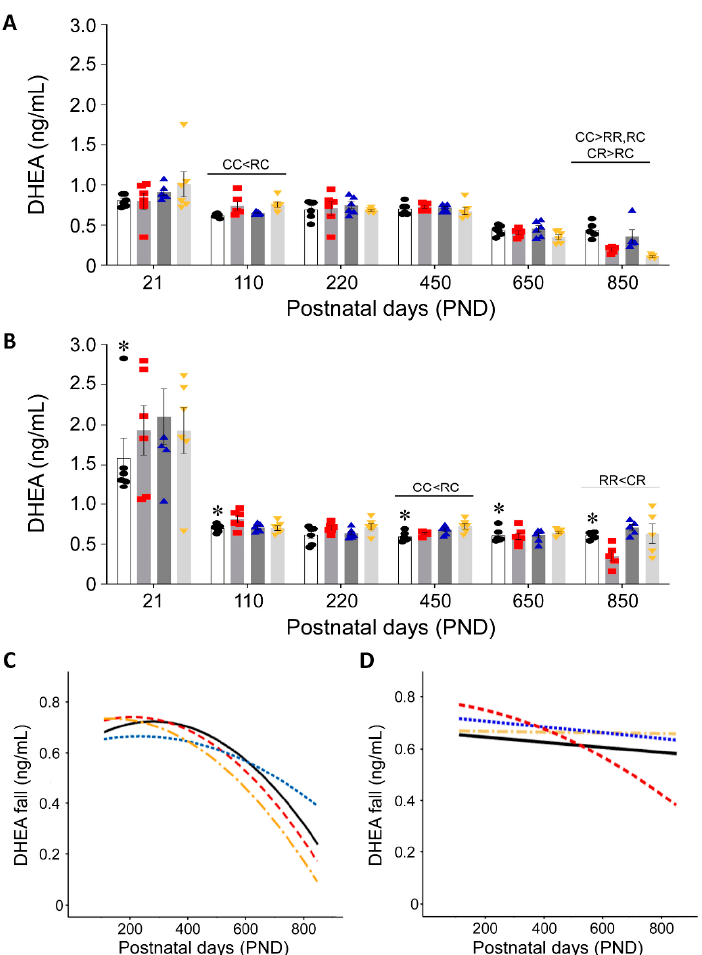
Figure 3. Serum DHEA in ( A ) male and ( B ) female: CC (open histograms, black circles), RR (grey histogram, red squares), CR (grey histogram, blue triangles) and RC (light-grey histogram, yellow inverted triangles) Data are mean ± SEM, group n = 6 per group at all ages except PND 850 where n = 5. Differences between the groups of the same sex are indicated on the lines above each age ( p < 0.05). * p < 0.05 male vs. female in C groups at the same age. ( C ) male and ( D ) female show best-fit curves for the DHEA fall in each group: CC solid black, RR red dash, CR blue dash and RC yellow dash line.